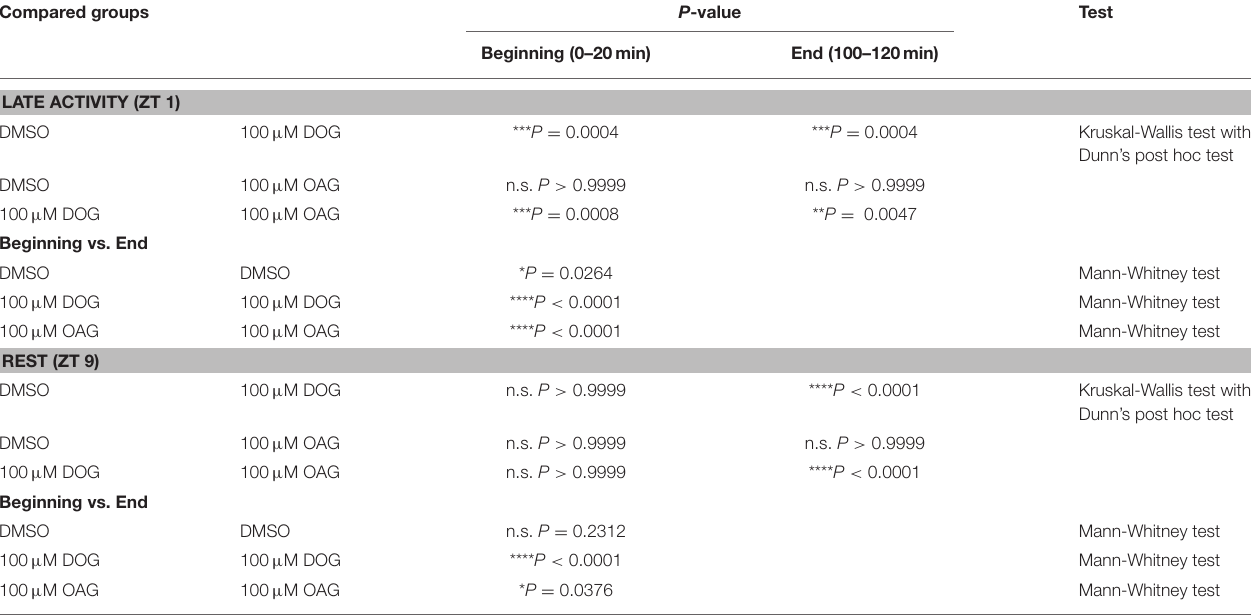
TABLE 4 | Statistical analysis of the latencies of the first bombykal-induced AP in the presence or absence of 100 µ M DOG or OAG during the late activity phase and at rest ( Figure 7 ). Compared